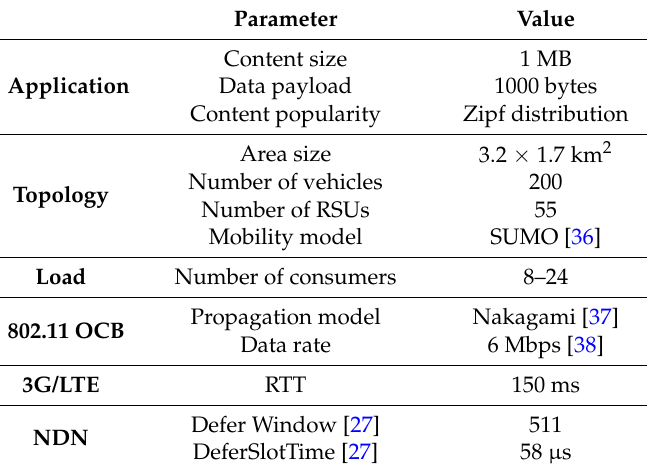
Table 1. Simulation